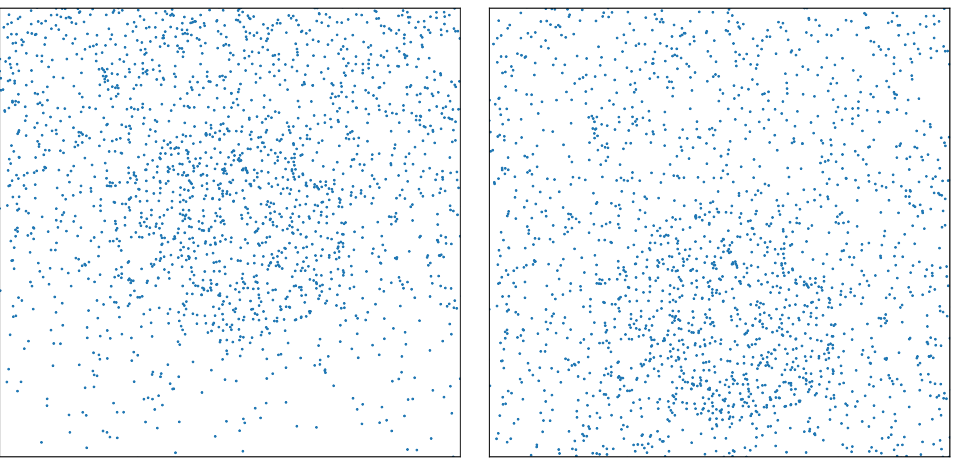
Figure 32 . The point data for the example with linearly increasing background considered in section A.1 before (left panel) and after (right panel) the probability integral transform (A.2).